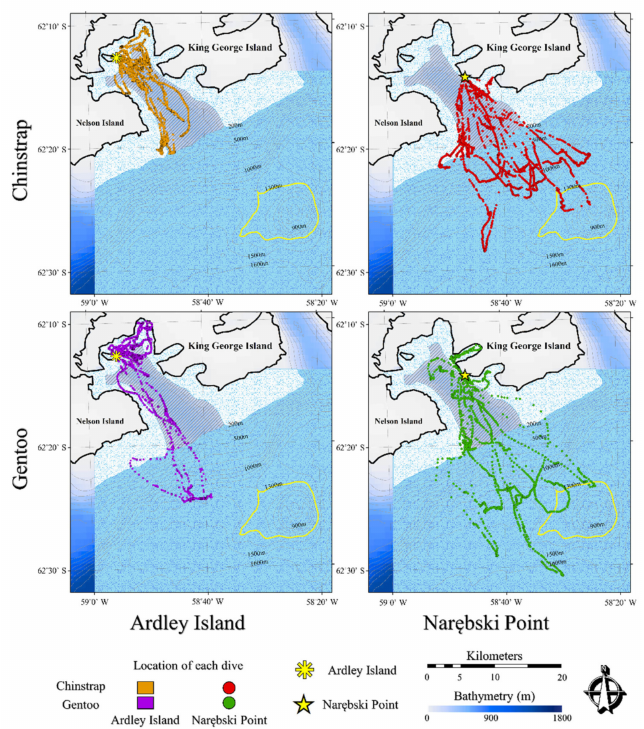
Figure 2. Spatial visualization of the foraging dive locations of Chinstrap and Gentoo penguins at Ardley Island (AI) and Nar˛ebski Point (NP). The bathymetric contours are categorized as the